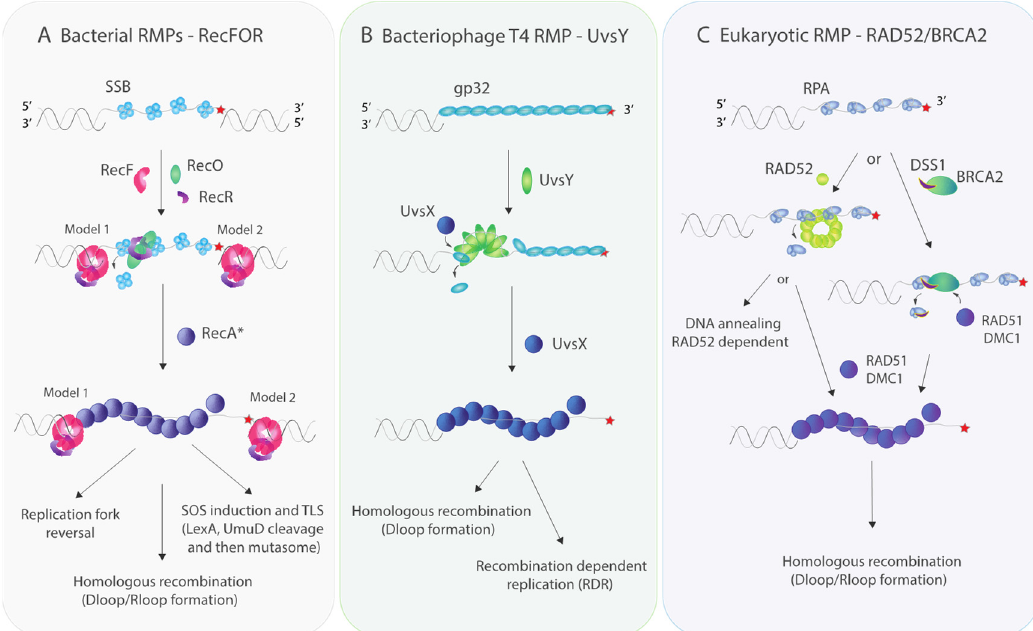
Figure 1. Recombination mediators facilitate recombinase loading. ( A ) Bacterial RMPs –RecF, RecO and RecR—facilitate loading of RecA recombinase. Two models have been proposed in the literature. Model 1 suggests that RecFR favors RecA nucleation at the 5 ′ end of the gap [76]. Model 2 proposes that RecFR bound to 3 ′ end limits RecA filament extension beyond the gap [64,75]. Both models describe RecO displacing SSB in the presence of RecR on ssDNA to facilitate RecA loading. In spite of a clear genetic relationship to RecO, the role of RecF is unclear. No complex containing both RecO and RecF has ever been detected and recent results lead to questions about the status of RecF as an RMP. ( B ) Bacteriophage T4 RMP—UvsY—adopts a multimeric ring-like shape [80]. Multimers of UvsY then destabilize gp32 filaments by bending the DNA and exchange gp32 with UvsX recombinase molecules via direct interaction, thereby stabilizing UvsX presynap- tic filaments [80–82]. ( C ) Eukaryotic RMP—RAD52—forms undecamer rings [83] which can promote RAD52-depedent DNA annealing and RAD51 D-loop formation [84–86]. Eucaryotic RMP—BRCA2—interacts with DSS1 and ssDNA, whereby DSS1 breaks up multimers of BRCA2, forming active BRCA2 monomers on ssDNA [87–89]. These BRCA2 mon- omers then load RAD51 alone (mitosis) or both RAD51 and DCM1 (meiosis) onto ssDNA [47,88,89]. In the process of RAD51/DMC1 recombinase loading, DSS1 competes RPA off ssDNA either prior to or in the process of recombinase loading.